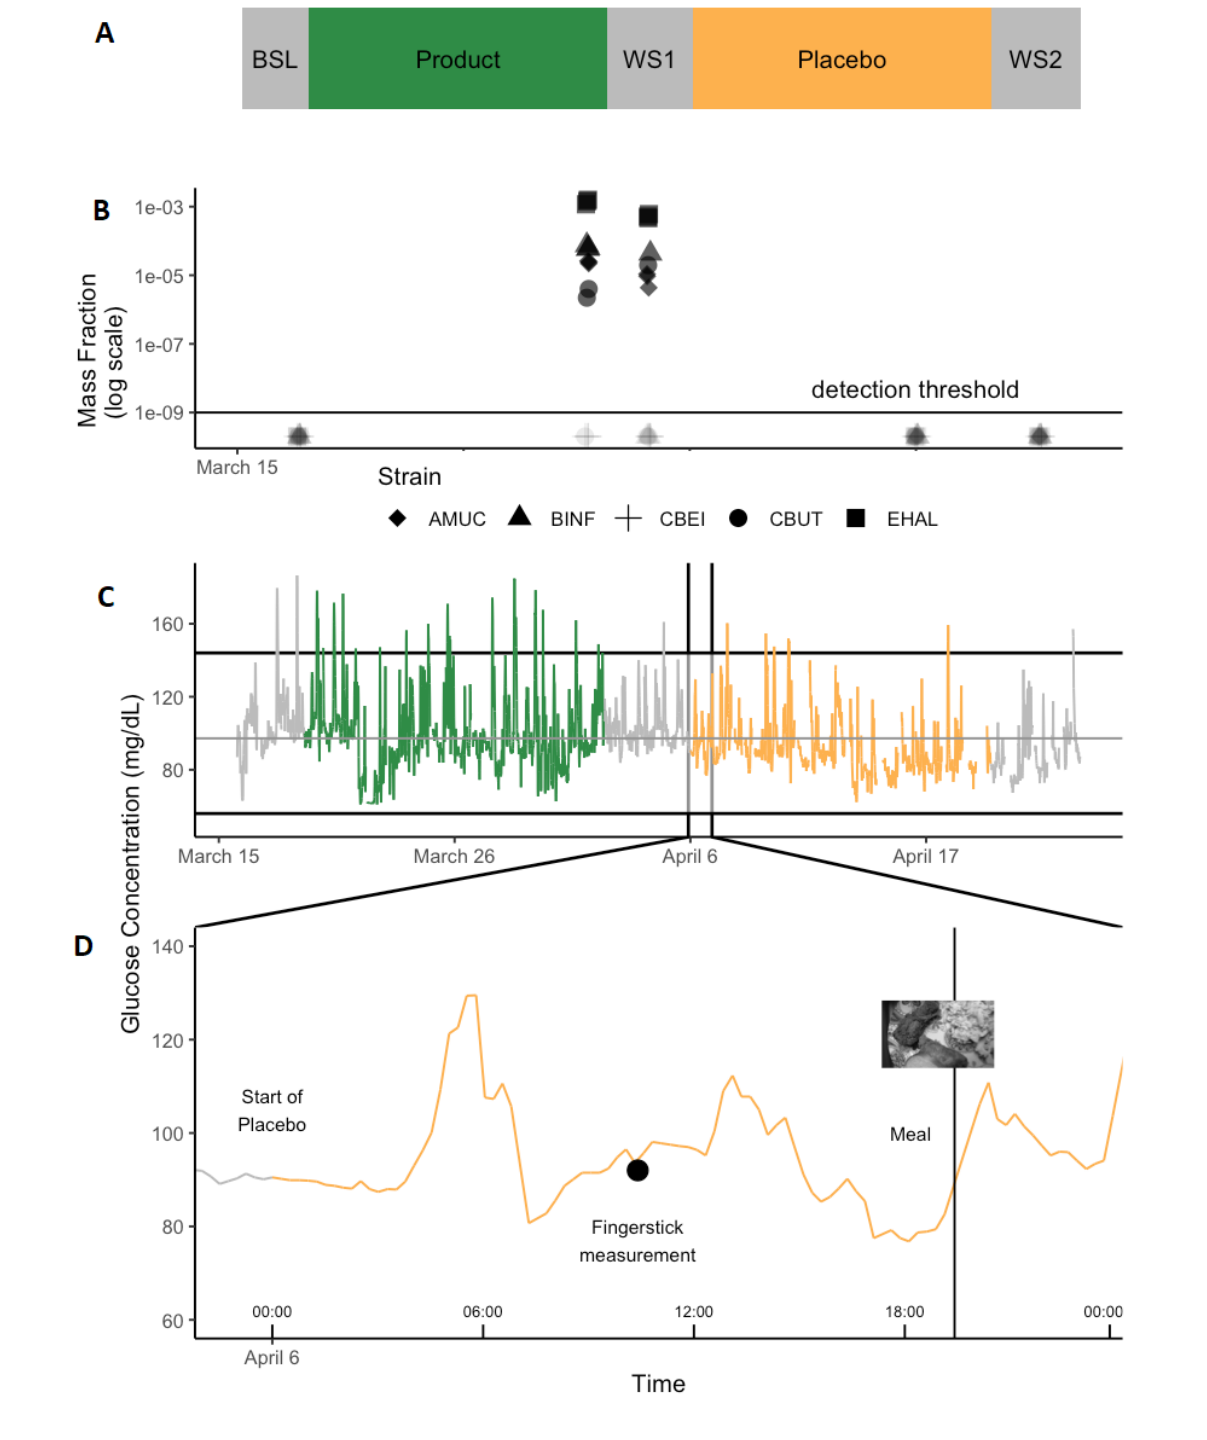
Figure 1. Glucose and dietary data collected for one subject. All data types collected for one subject. (A) Subject 1 starts in the active product arm (14 days) and then moves to the placebo arm (14 days). (B) At baseline, the end of each period, and study end, the subject provides stool samples. Strains present in the product are detected at the end of the active product period and a little after (arrow mark). (C) Continuous glucose monitoring (CGM) glucose levels are also tracked throughout the 6 weeks. (D) The values can be compared to the fingerstick measurements or used in coordination with pictures taken (here chicken wings at 7 PM) to detect meal-related glucose excursions. AMUC: Akkermansia muciniphila ; BINF: